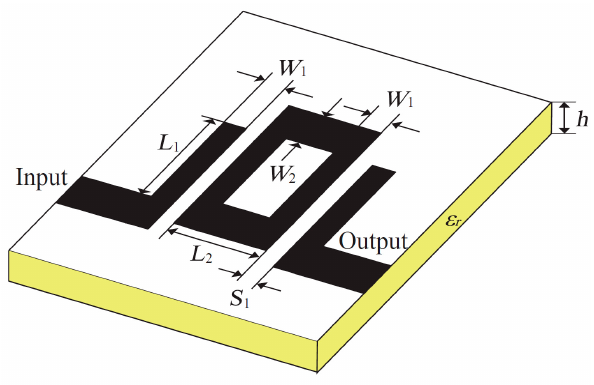
Figure 3. Second-order ring resonator bandpass microstrip filter: geometry [12,17].